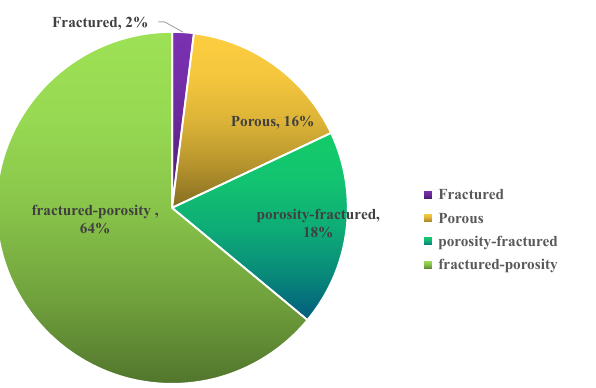
Figure 13. Distribution of PL buried-hill reservoir types. The data were obtained through logging data interpretation.